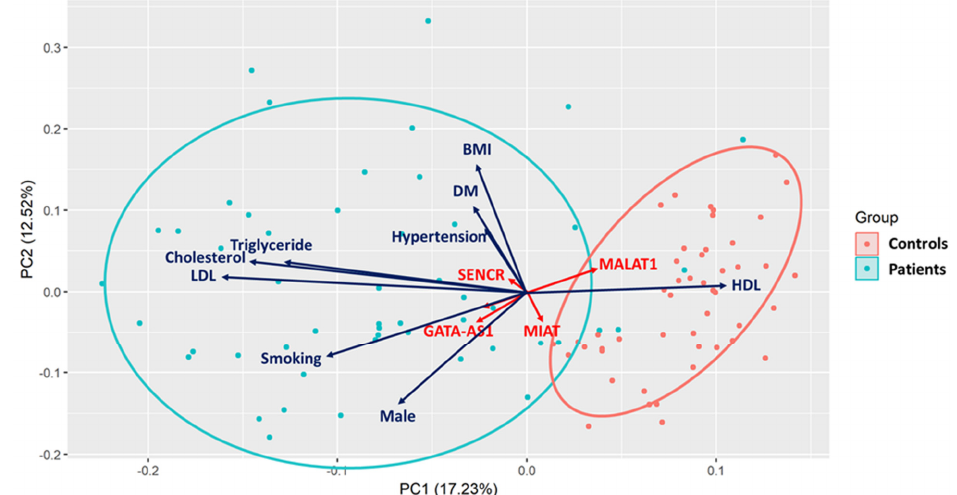
Figure 2. Multivariate analysis for combined environmental variables and the studied genetic variants. Arrow length in- dicates the strength of the effect, while direction indicates the vector. The red-colored circle (the right one) encloses the control group, while the teal-colored circle (the left one) encloses the patient group. N.B. All the studied (genetic and non- genetic) variables were included in a preliminary principal component analysis, then the significant variables were only shown.